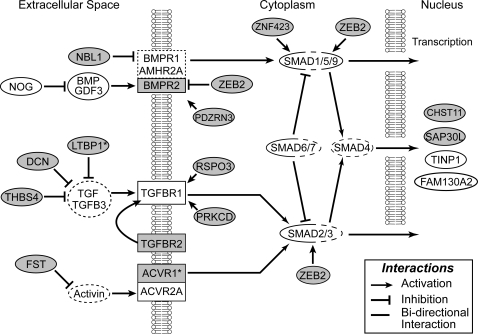
Gene abbreviations are in the text and Tables S1 and S3.Rectangles constitute important nodes in the network that have receptor activities, genes presented in ovals play either a regulatory role, or are products of transcription (shown in the nucleus). Not all connections and nodes are included; genes not required for network assembly, or not present on the arrays were omitted for clarity. Rectangular and oval symbols depicted in grey indicate genes from our primary or secondary lists (asterisks), symbols or fractions of symbols shown in white were either not differentially expressed (solid) or not on our array (dashed). Major cellular compartments are indicated along the top or by the presence of phospholipid membranes.